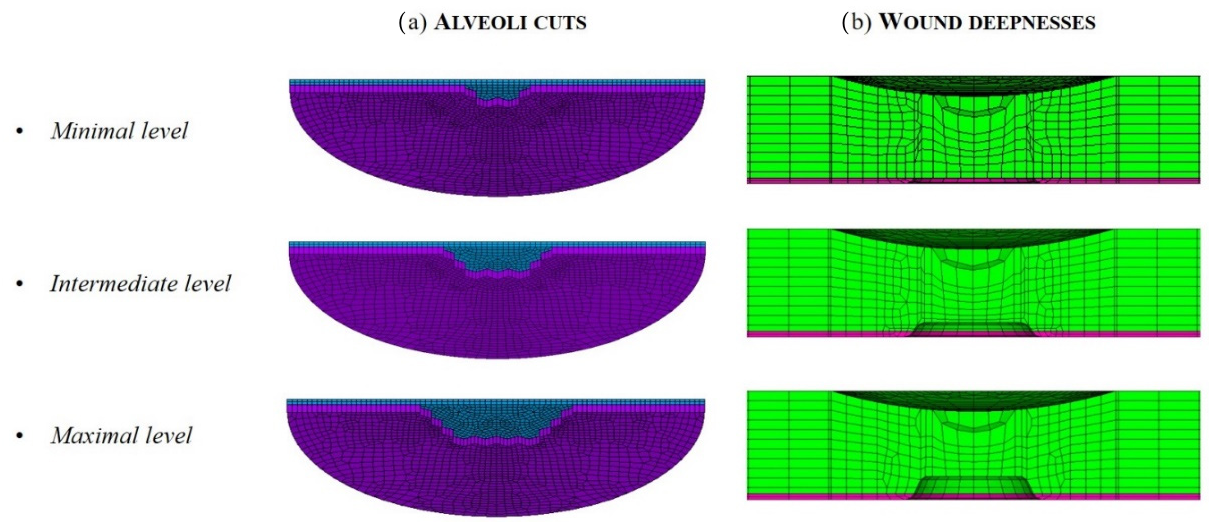
Figure 3. Minimal, intermediate, and maximal levels of the alveoli cutting ( a ) and wound deepness ( b ) parameters. Table 2. Parameters’ minimal, intermediate, and maximal values used as levels for the experimental points of the sensitivity